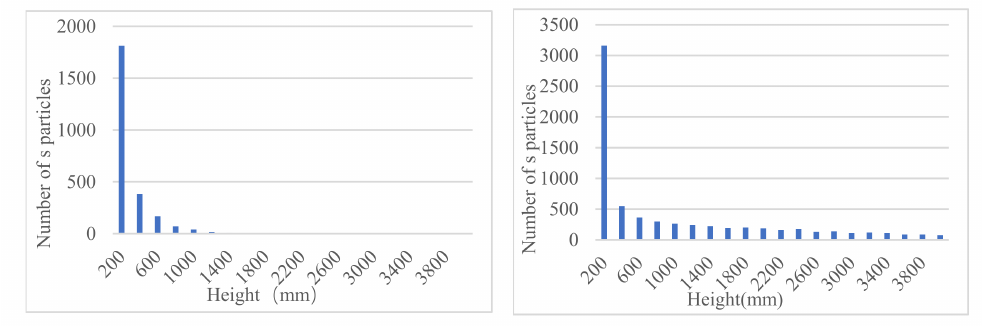
Figure 11. The number of particles at 1 s and 3 s.